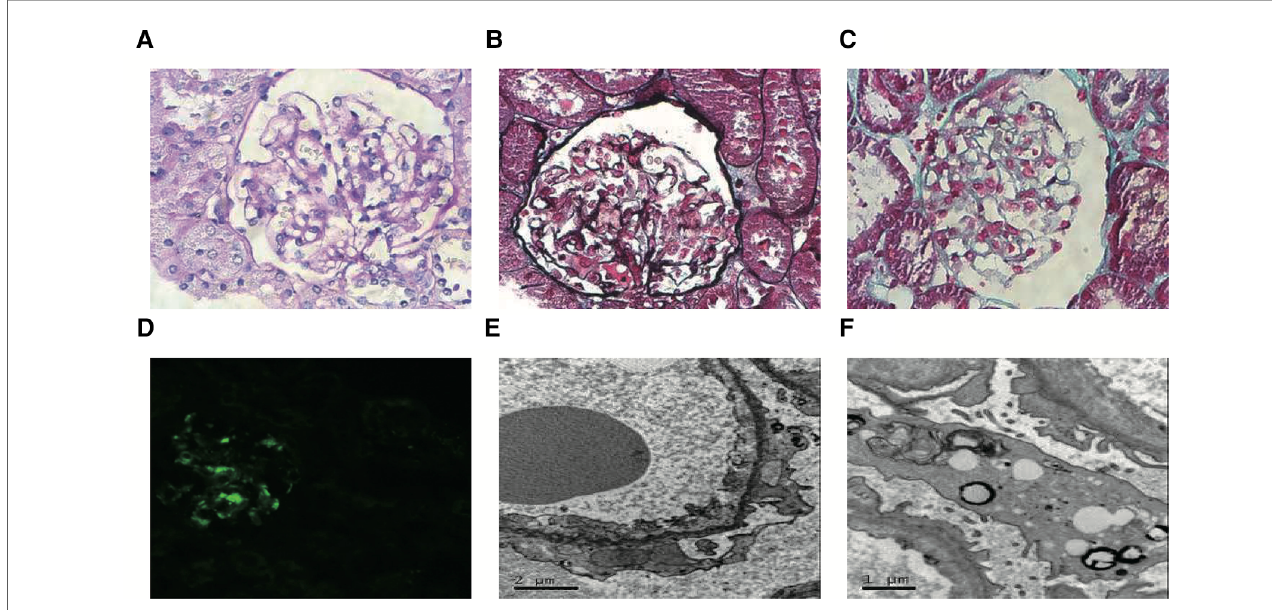
FIGURE 1 Representative images of renal pathology in case 1. Light microscopy: Most glomerular segmental mesangial cells were mildly hyperplasia, and the mesangial stroma was hyperplasia. There was no obvious lesion in the glomerular basement membrane, and no dense deposits were seen under the endothelial and epithelium. Renal tubular epithelial cells showed degeneration. Atrophy was seen in some segments of renal tubules, and the basement membrane of renal tubules was thickened in some segments. The renal interstitium was widened, and fl aky fi brosis was seen. ( A , PAS, magni fi cation×400; B , PASM, magni fi cation×400; C , Masson, magni fi cation×400). Immuno fl uorescence microscopy: IgM (+++) was deposited in the glomerular mesangial region and capillary wall as a mass of immuno fl uorescence. ( D , magni fi cation×200). Transmission electron microscopy: Most segments of the capillary basement membrane had no obvious lesions, and a few segments showed mesangial insertion. The rough endoplasmic reticulum in podocytes expanded, mitochondria swelled, small lipid droplets and lysosomes increased slightly, and foot processes fused widely. The mesangial matrix was mild to moderate hyperplasia, and a small amount of the dense deposits was seen in the mesangial area ( E,F ).